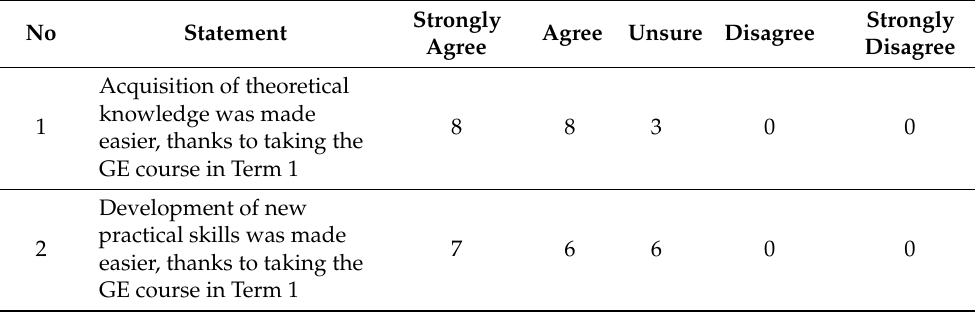
Table 5. Perceived impact of GE course experience on learning gains in LTA